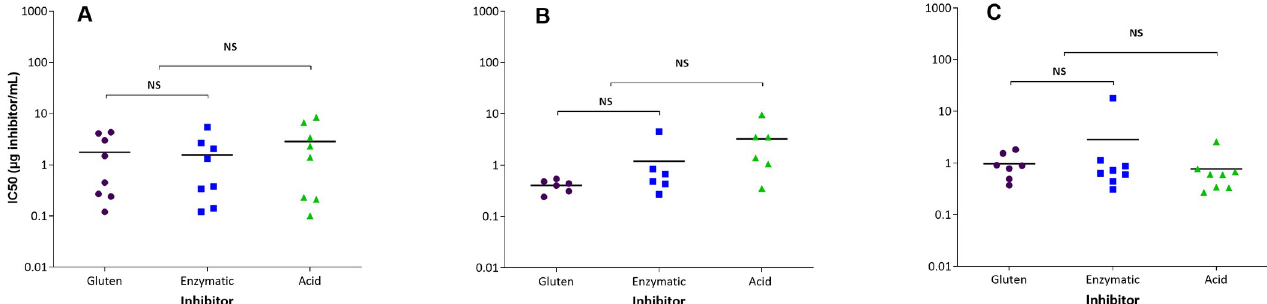
Fig 3. Inhibition ELISA. Sera from gluten tolerant rats immunized with Gluten (A), Enzymatic hydrolyzed gluten (B) or Acid hydrolyzed gluten (C) and inhibited with Gluten, Enzymatic or Acid hydrolyzed gluten.